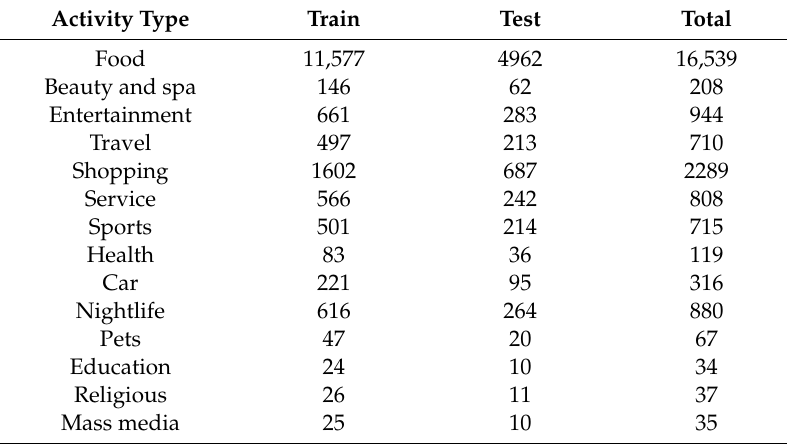
Table 2. Number of posts in each